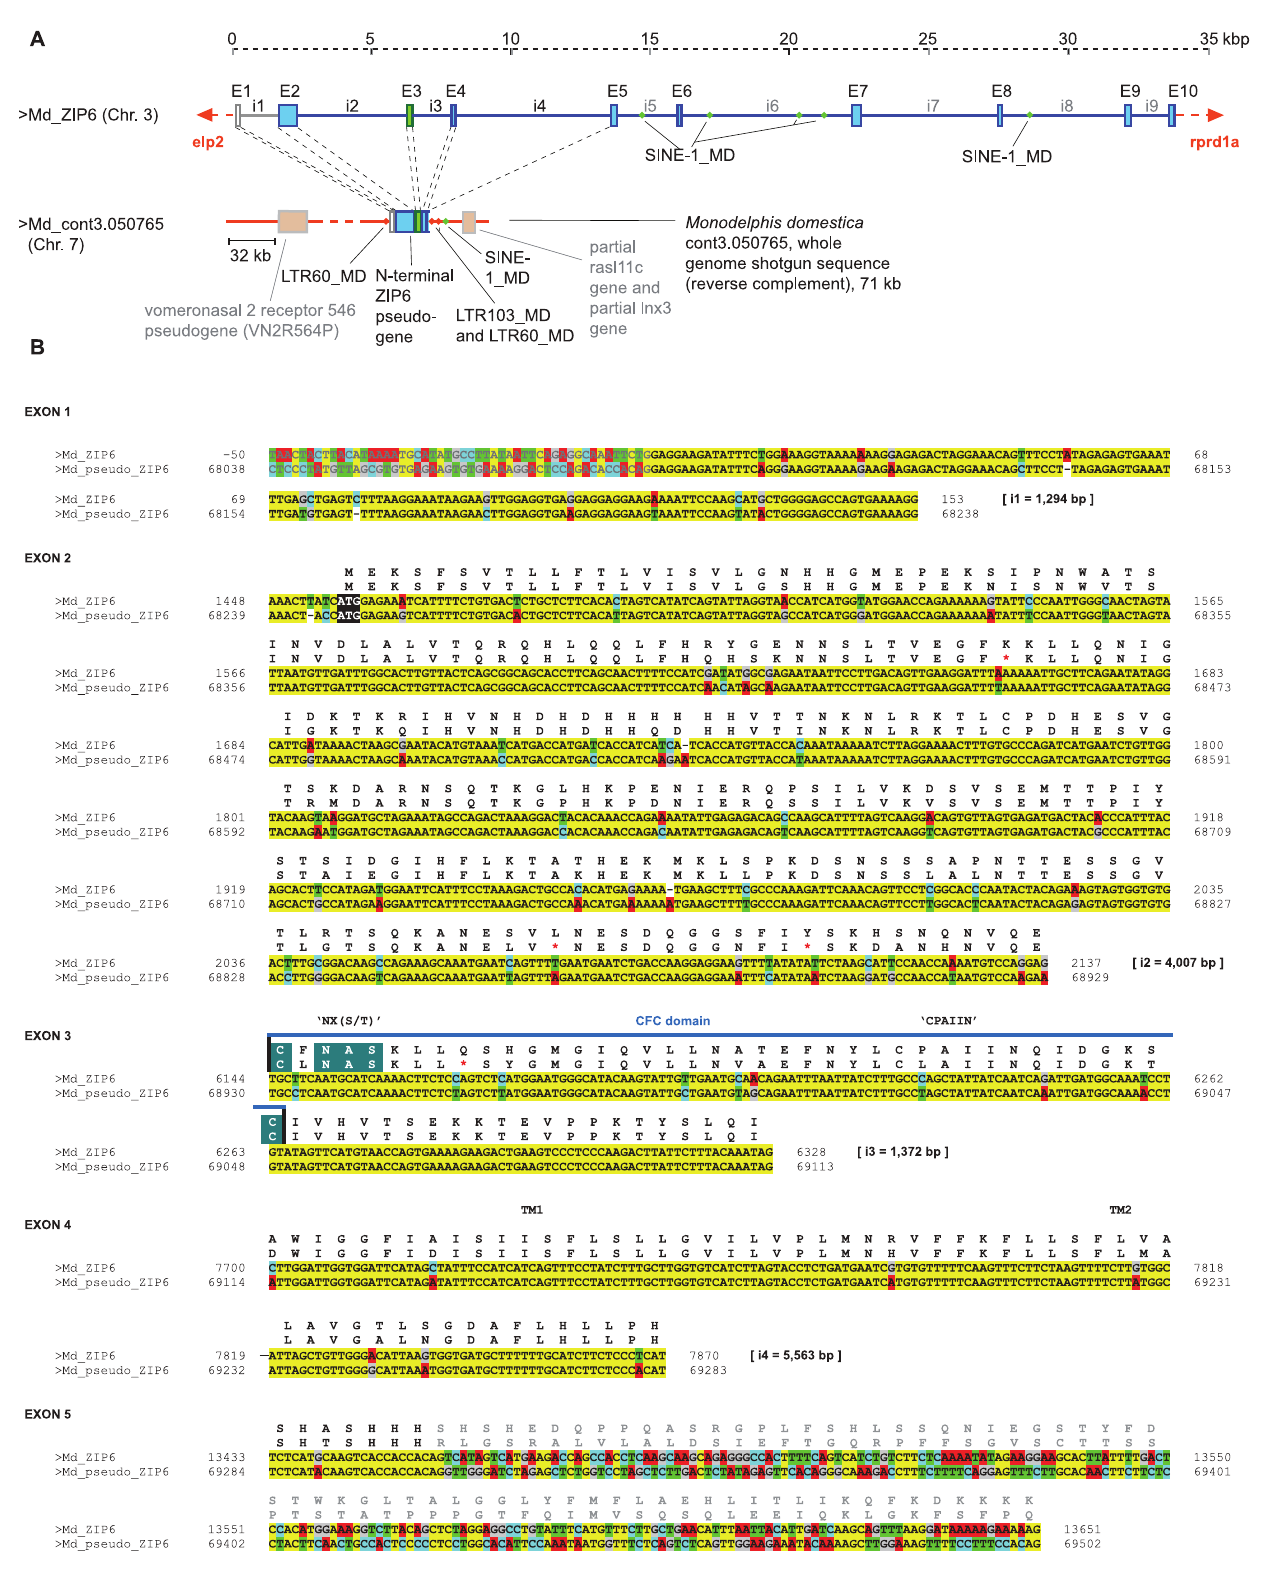
Figure 5. Evidence for a C-terminally truncated ZIP6 pseudogene in the opossum genome. A . An N-terminal ZIP6-like pseudogene was identified on chromosome 7 of Monodelphis domestica (cont3.050765, GenBank: AAFR03050766.1), which consisted of exons 2, 3, 4 and parts of exons 1 and 5. Exon 3 which codes for the CFC is depicted in light green color. Long terminal repeats (LTRs) and short interspersed nuclear elements (SINEs) in the vicinity of the pseudogene are marked. Please note that short direct repeats immediately flanking the pseudogene were not detected. Similarly, no evidence of a poly-A tail could be observed, consistent with the retroinsertion of a C-terminally truncated ZIP6 transcription product. B .